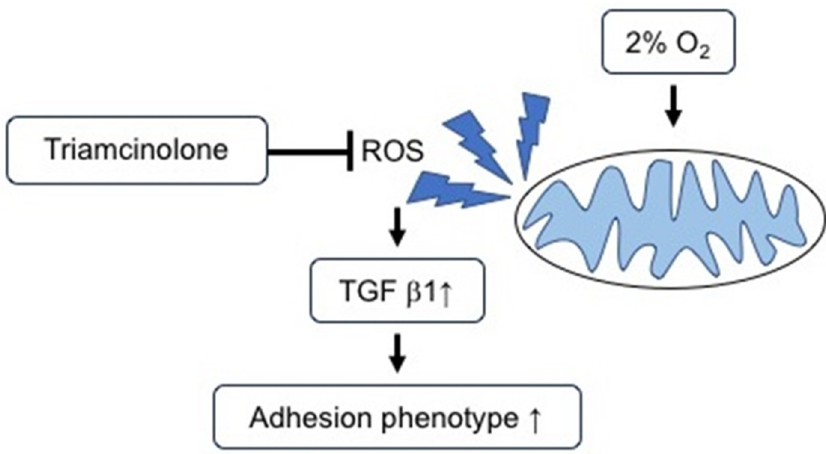
Figure 5. Triamcinolone prevents the increase in ROS and the subsequent release of TGF- β 1 at 2% hypoxia, found in the peritoneum.